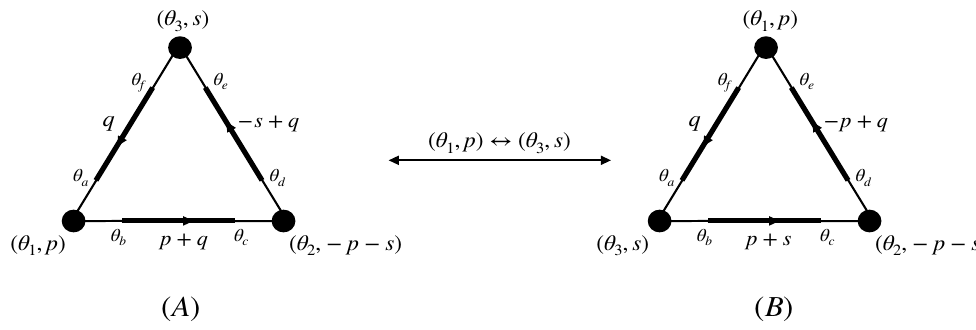
Figure 4 . The full J 0 3 point function is obtained by connecting three exact J 0 -vertices with exact propagators. There are two such diagrams, as shown above, which turn out to be